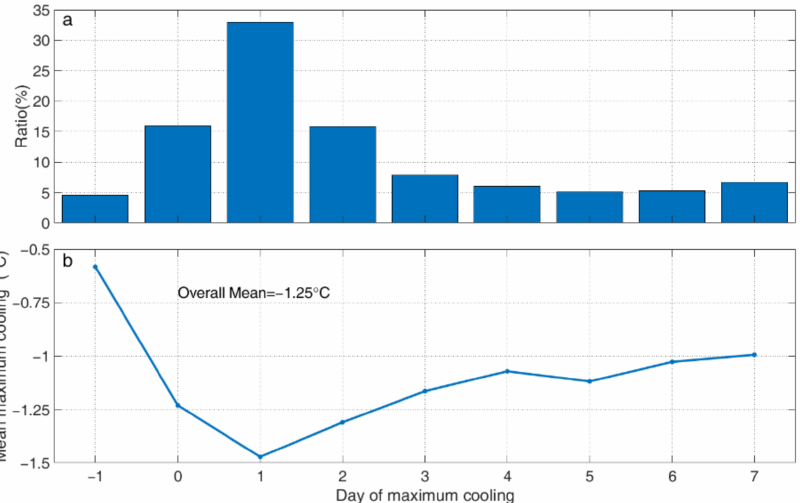
Figure 2. ( a ) Observed frequency (%) of the day of maximum cooling occurrence and ( b ) the corresponding mean maximum cooling for each day. D0 denotes the time of TC